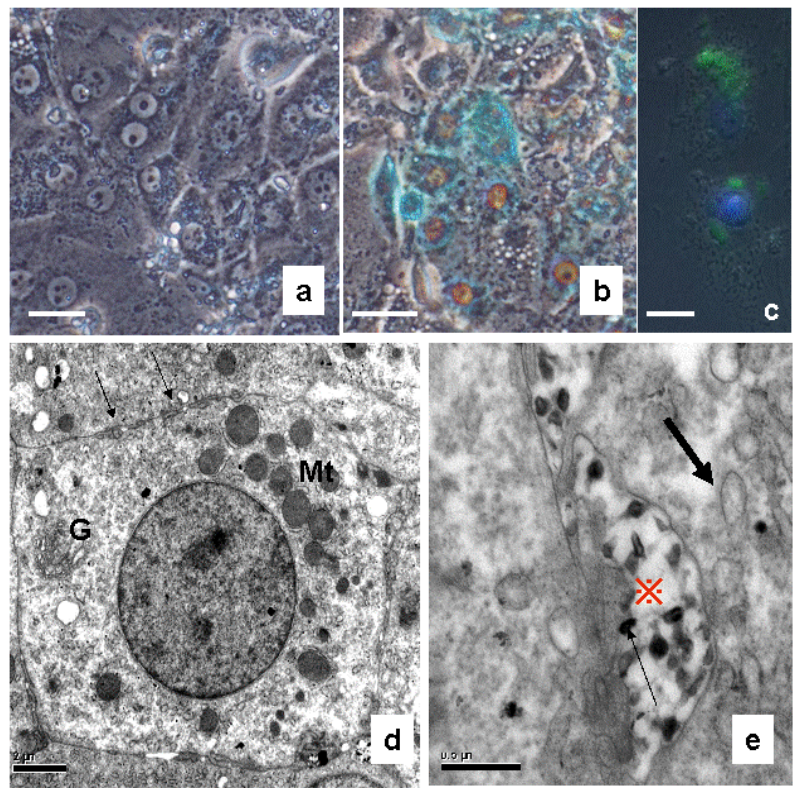
FIGURE 3 . Hepatocyte differentiation (KhES 3). (a) Phase-contrast image of EB outgrowth on day 23. The cell cluster consists of large cells with a round nucleus or two nuclei. Bar = 70 µ m. (b) Partial uptake of ICG (green) in the cell cluster. Bar = 70 µ m. (c) Green-fluorescent albumin- positive large cells contain many intracellular organellae. Bar = 20 µ m. (d) TEM image of the ICG-positive cell that contains a large round nucleus, rich round mitochondria (Mt), Golgi apparatus (G), and bile canaliculi (arrows). Bar = 2 µ m. (e) Bile canaliculi (shown in red) develop well in these cells, in which high-density structures are plentiful and seem to be associated with ICG granules (fine arrow). Irregular vesicles without ribosomes are distributed near the canaliculus, suggesting poorly developed sER (bold arrow). Bar = 0.5 µ